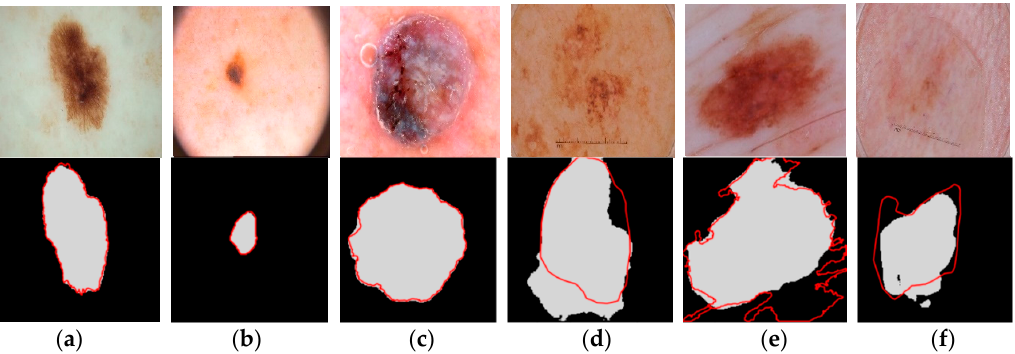
Figure 13. High and low dice coefficient examples (above-given images are original images in validation set). High dice coefficients: ( a ) 98.26%, ( b ) 98.87% and ( c ) 97.74%. Low dice coefficients: ( d ) 68.41%, ( e ) 64.97% and ( f ) 71.58%.